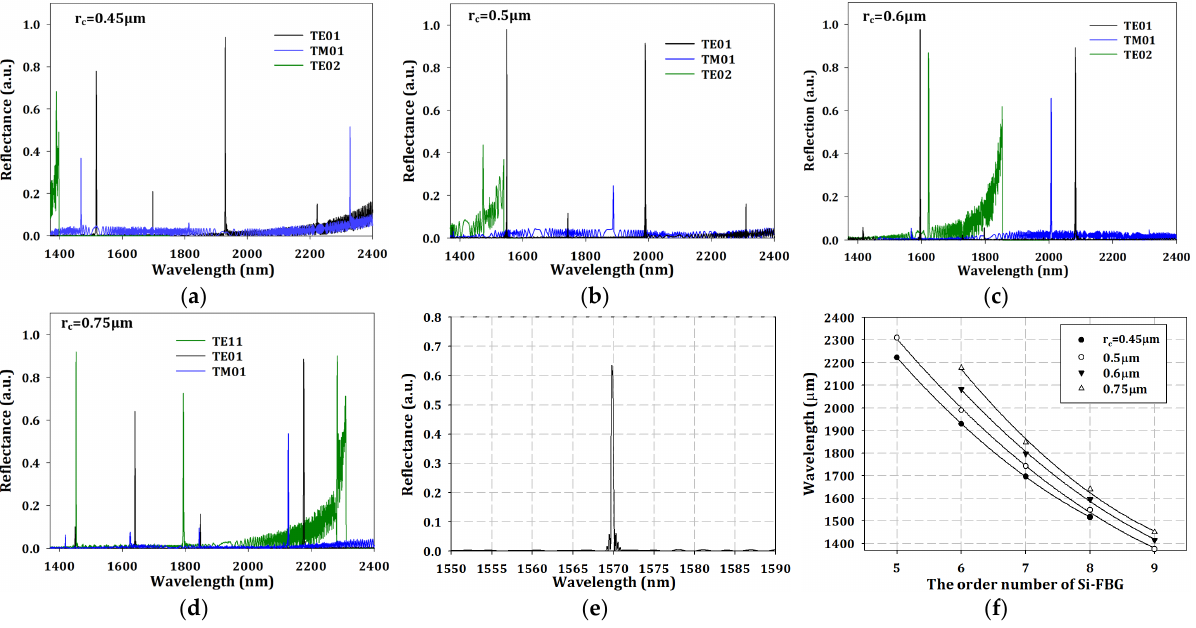
Figure 3. The output spectrum with different transmission modes and ( a ) r c -0.45μm, ( b ) r c -0.5μm, ( c ) r c -0.6μm, ( d ) r c -0.75μm, ( e ) the output spectrum with 1794 nm grating period, and ( f ) the trends in wavelength and order number of grating.